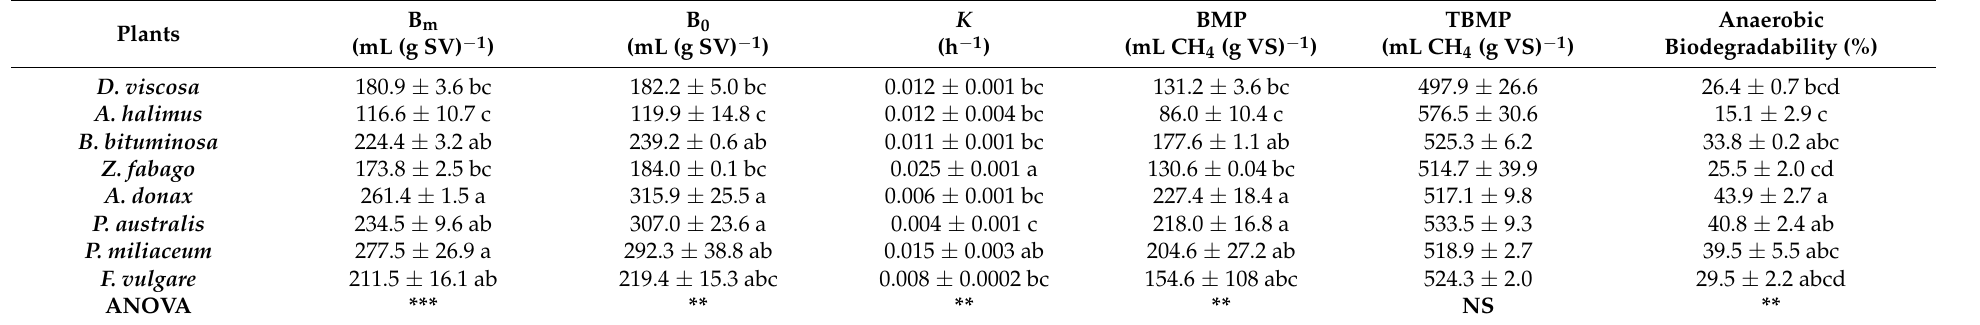
Table 4. Results of the anaerobic degradation of the plants: the parameters of the first-order kinetic model, biochemical methane potential (BMP), theoretical biochemical methane potential (TBMP) and anaerobic biodegradability (mean ± se; n = 2).